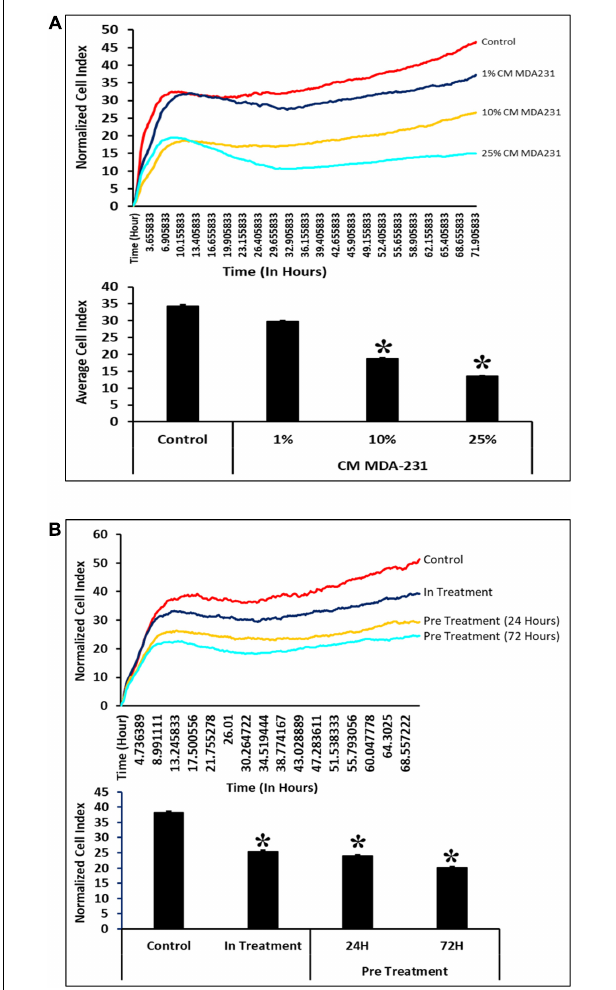
FIGURE 3 | Comparison of functional outcome of CV-MSCs before and after CM-MDA231 preconditioning. Proliferation assessment by xCELLigence RTCA system after cells were treated with 1–25% of CM-MDA231 for 72 h (In-treatment) while performing the assay. CV-MSC proliferation reduced significantly at 10 and 25% treatment conditions as compared to 1% and untreated control (A) . Significantly, reduced proliferation was observed in CV-MSCs preconditioned for 24 and 72 h as well in the in-treatment conditions (at 25% CM-MDA231 concentration, while performing the assay) as compared to untreated control (B) . Experiments were performed in triplicate using cells at passage 3 prepared from five individual placentae. Bars represent standard errors * P ≤